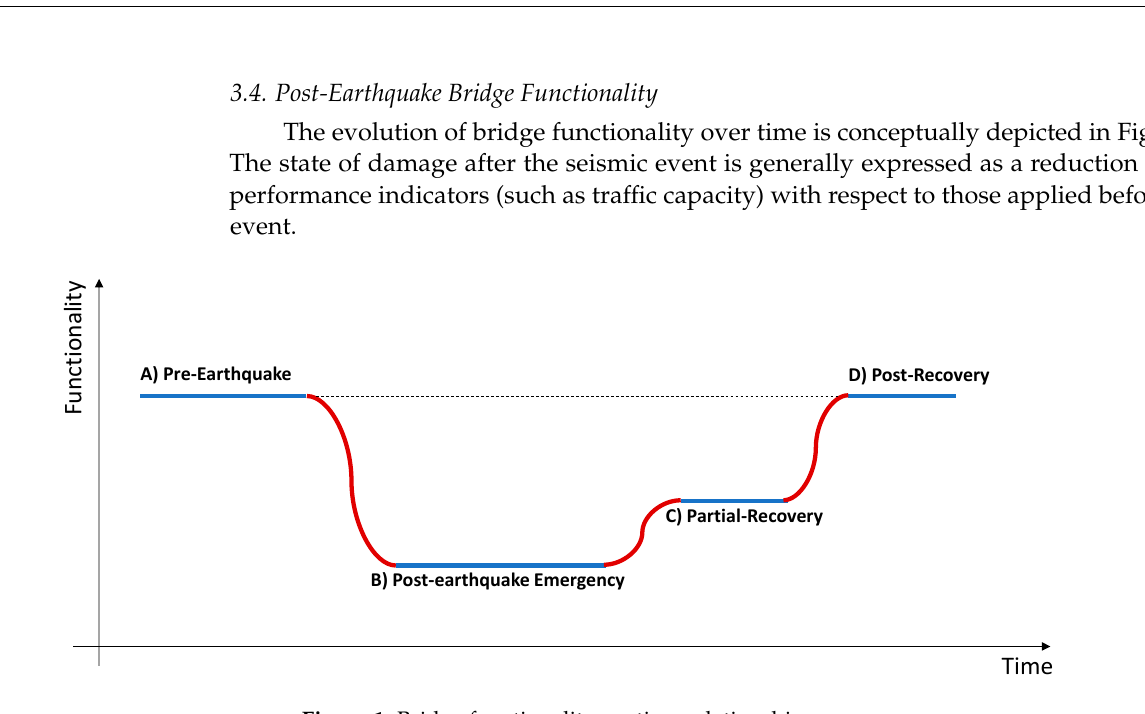
Figure 1. Bridge functionality vs. time relationship.